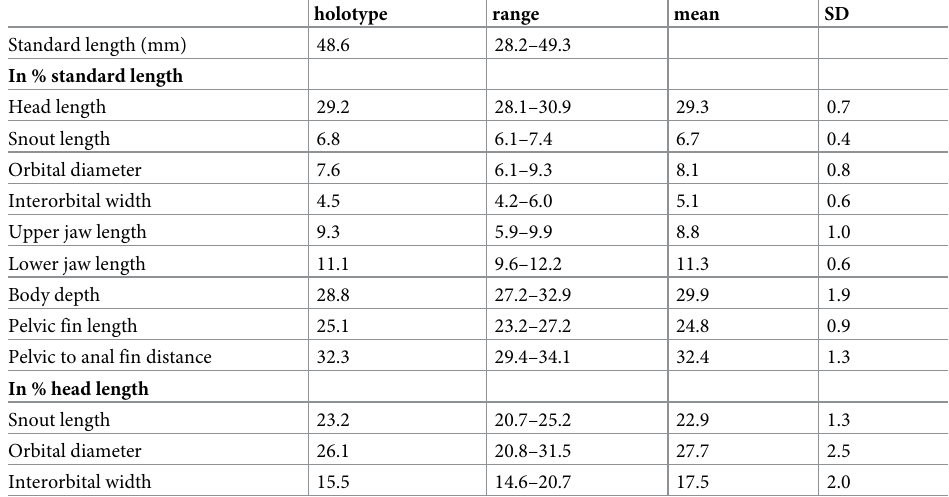
Table 1. Biometric data for Badis kaladanensis (ZSI FF 5404, 5405; PUCMF 15001, 15002, 15003) (n = 19). Ranges include value of